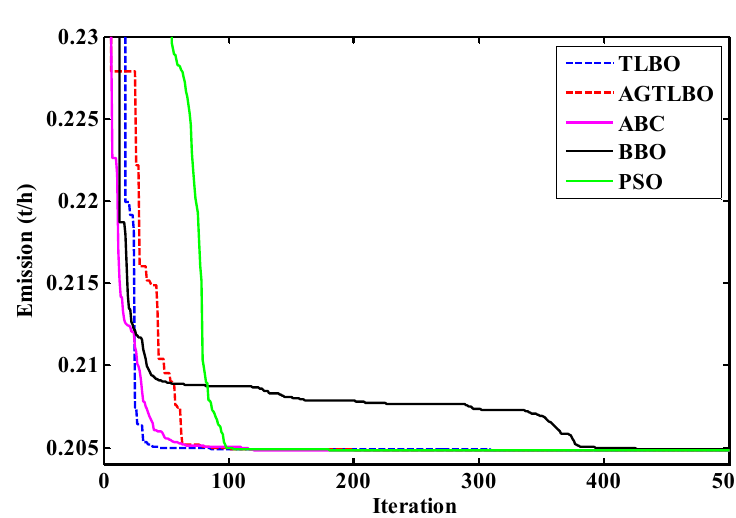
Figure 8. Convergence of algorithms for Case 2.